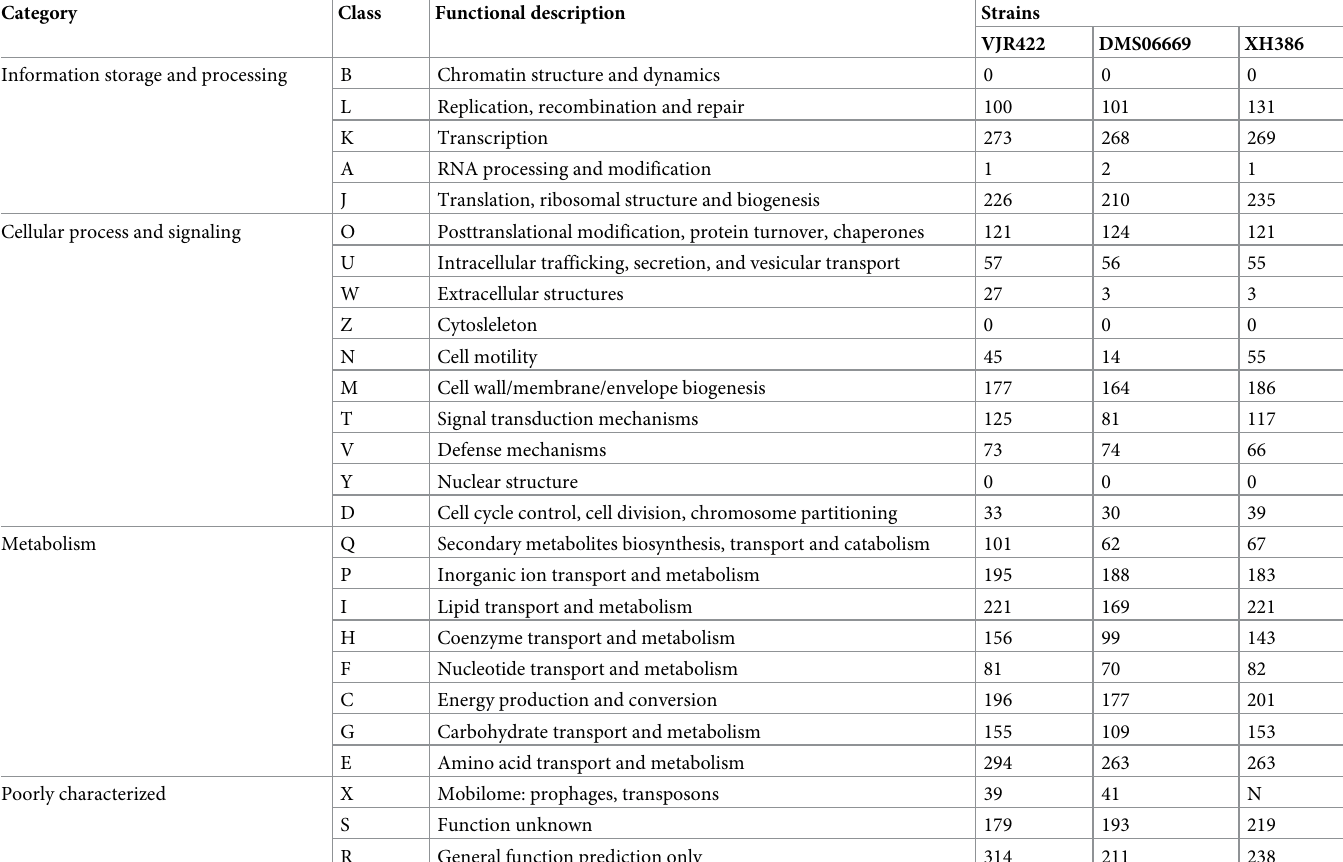
Table 3. Comparison of COG among the genome of A . baumanni strain VJR422, DMS06669, and XH386. Category